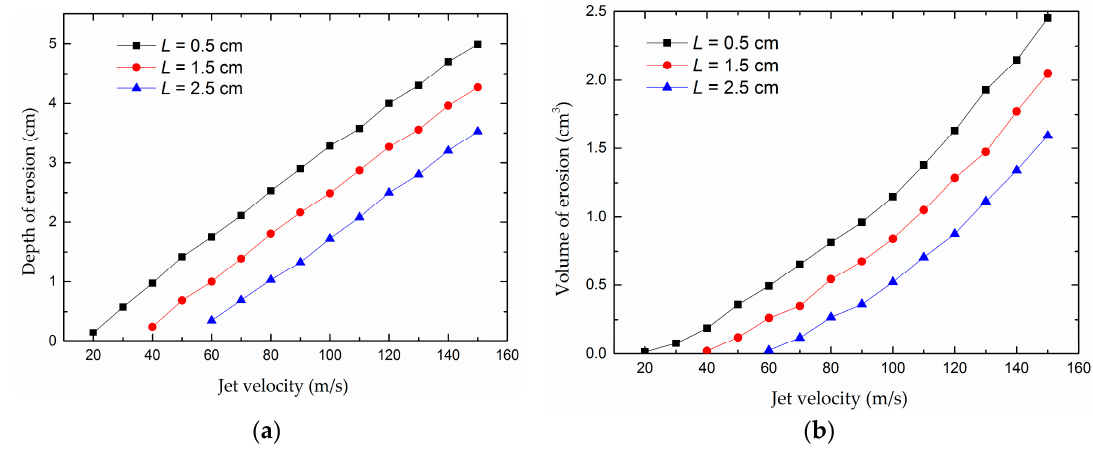
Figure 8. Jet velocity influence on the depth of erosion and the volume of erosion. ( a ) Depth of erosion; ( b ) volume of erosion.